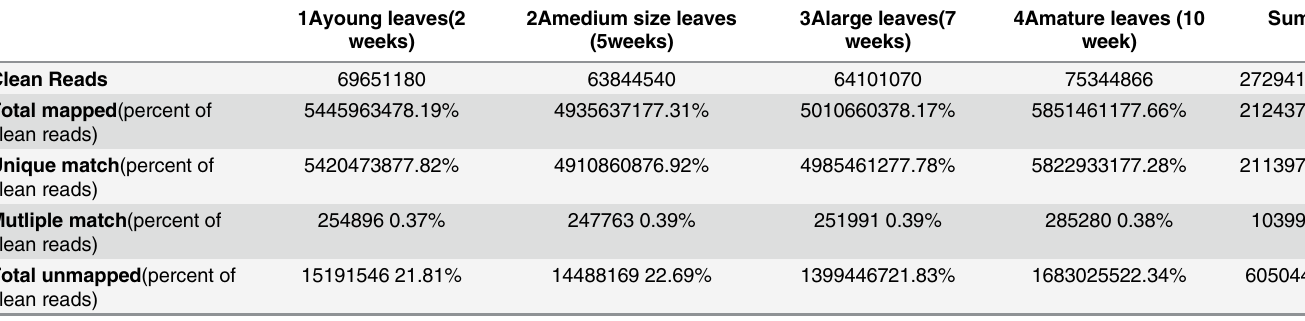
Table 1. Number of reads sequenced and mapped to the grapevine